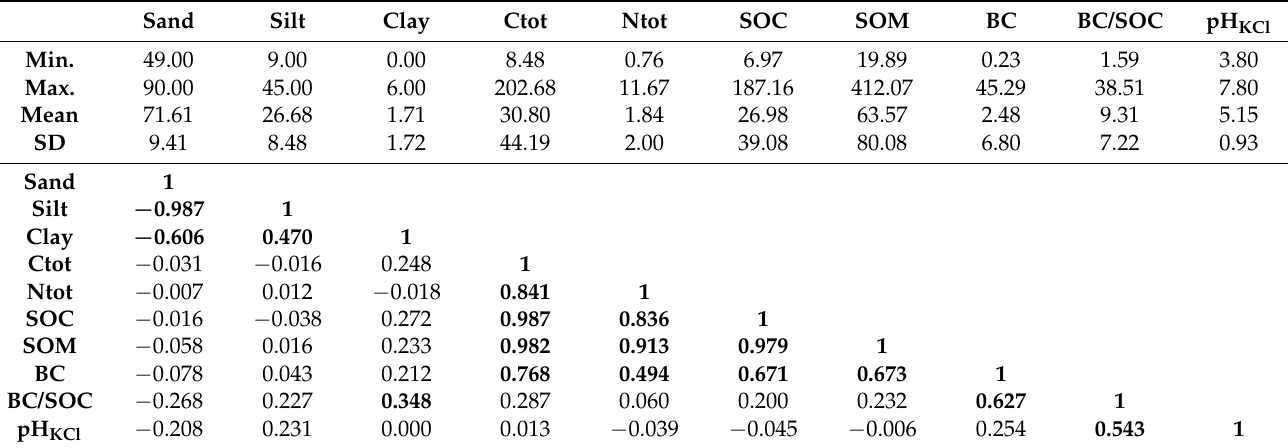
Table 1. Summary statistics of soils samples and correlation matrix of soil properties ( n =